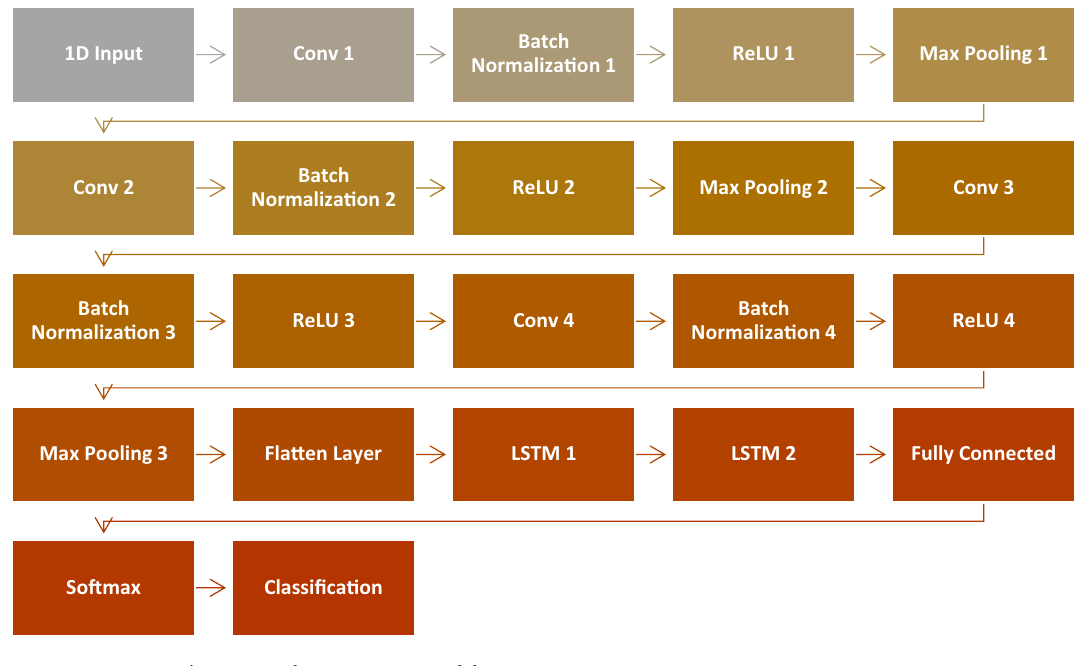
Figure 5. The proposed CNN-LSTM